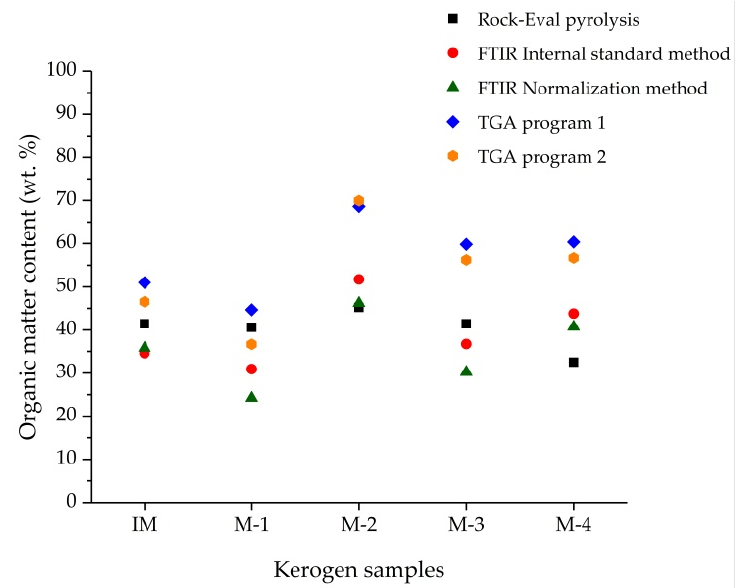
Figure 5. Comparison of organic matter (OM) content in kerogen samples from the Nyurolskaya Depression (IM) and the Krasnoleninskiy Arch (M-1–M-4) evaluated by Rock-Eval pyrolysis, TGA (Program 1: the same standard thermogram of Rock-Eval TM and Program 2: standard program in the oxidizing atmosphere) and FTIR spectroscopy in transmission mode (normalization and in- ternal standard methods).